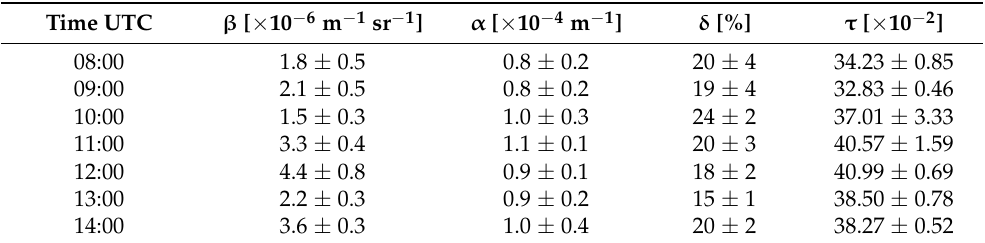
Table 2. The average values of the lidar-derived optical properties of the atmosphere for the 532 nm, determined in the Saharan dust layer, between 2.0–3.0 km for periods corresponding with the sun photometer scans, along with the aerosol optical depth in the vertical column of the atmosphere determined from sun photometer for the 500 nm.